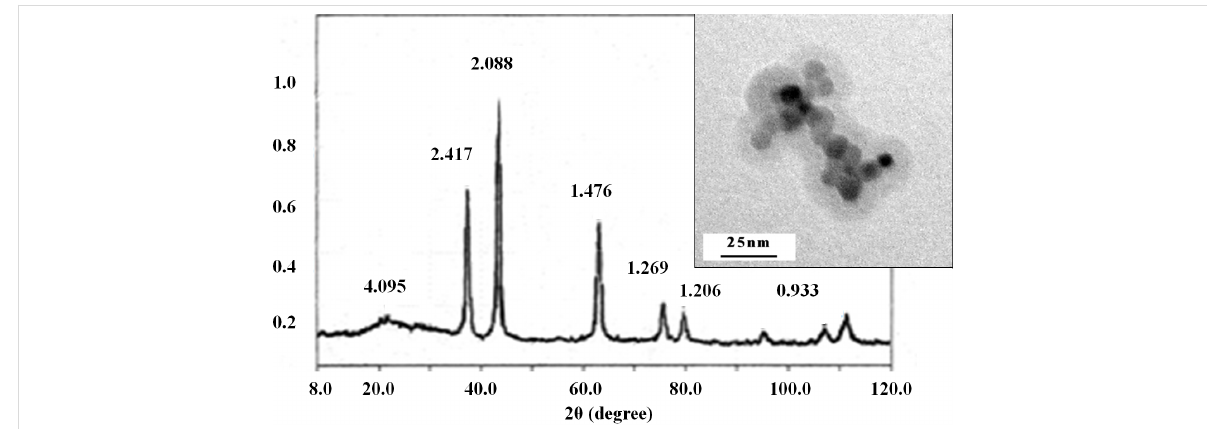
Figure 4: XRD pattern (DRON-3M, Russia) and TEM image (insert) of the NiO nanopowder.